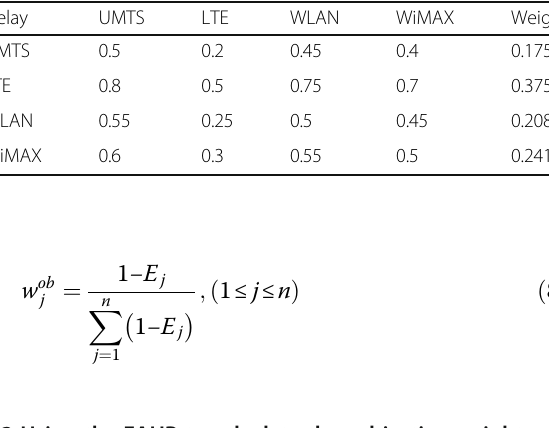
Table 14 Fuzzy consistent matrix and weights for loss